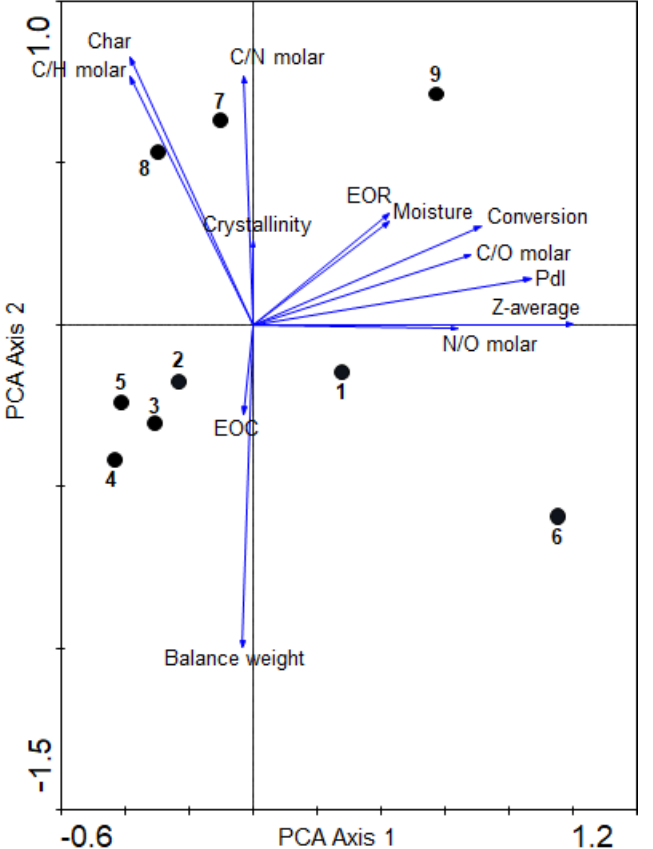
Figure 6. PCA biplot based on the physicochemical variables: C/N, C/O and N/O molar ratios; char (%); crystallinity (%); α (%) conversion; EOC and EOR; balance weight; Pdl; moisture (%); and Z-average (nm) for the polymers obtained. The relative proportions of the different variables are indicated by arrows, and polymers are indicated by dots.